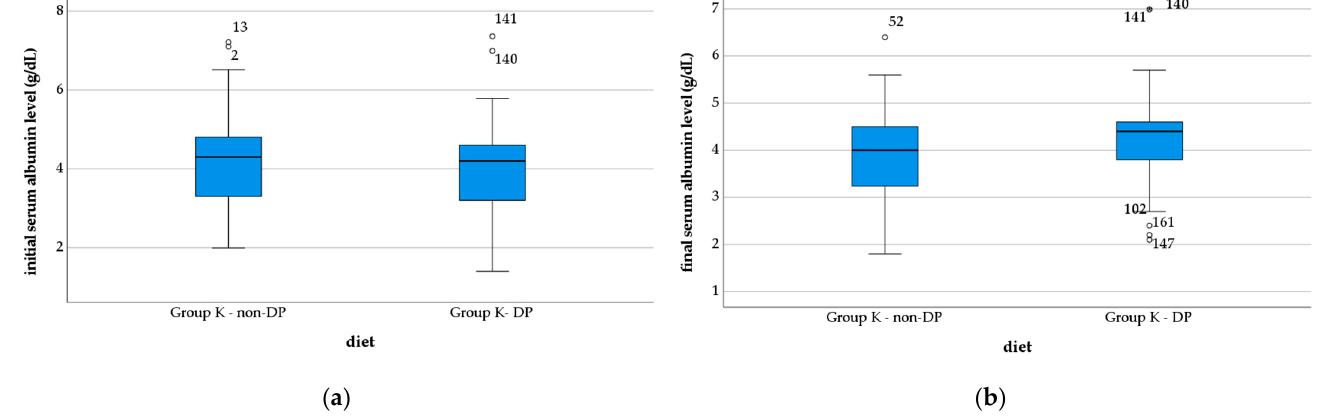
Figure 5. Evolution of the serum albumin level in the study groups: ( a ) initial vales; ( b ) final values. *, extreme outliers; o, mild outliers.